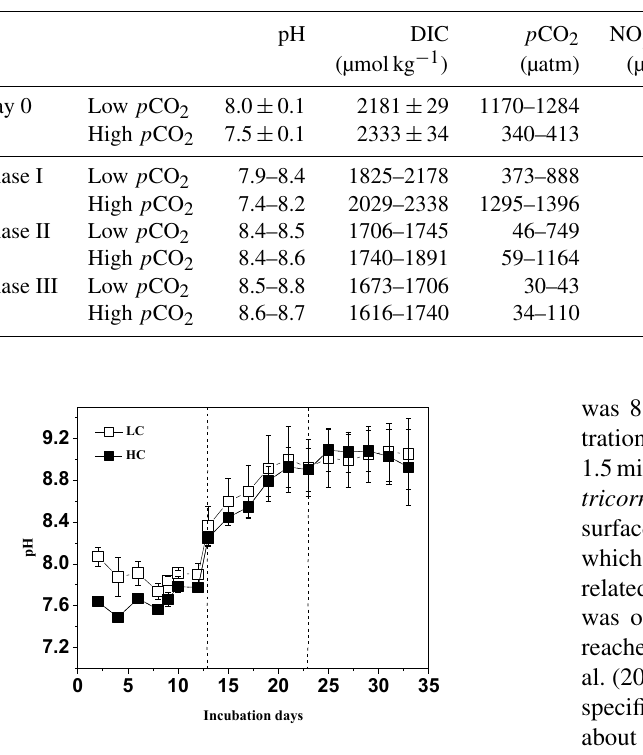
Figure 1. Temporal development of pH in the high p CO 2 (1000µatm, solid squares) and low p CO 2 (400µatm, white squares) mesocosms. Data are mean ± SD, n = 3 (triplicate independent mesocosm bags) (Origin